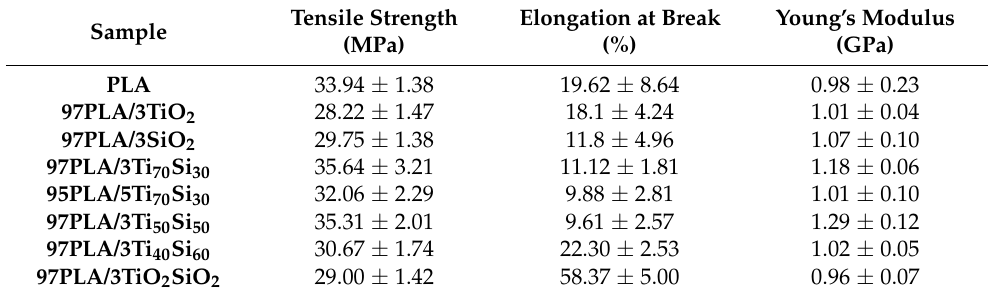
Table 1. Tensile properties of PLA, PLA/TiO 2 , PLA/SiO 2 , PLA/Ti x Si y , and PLA/TiO 2 SiO 2